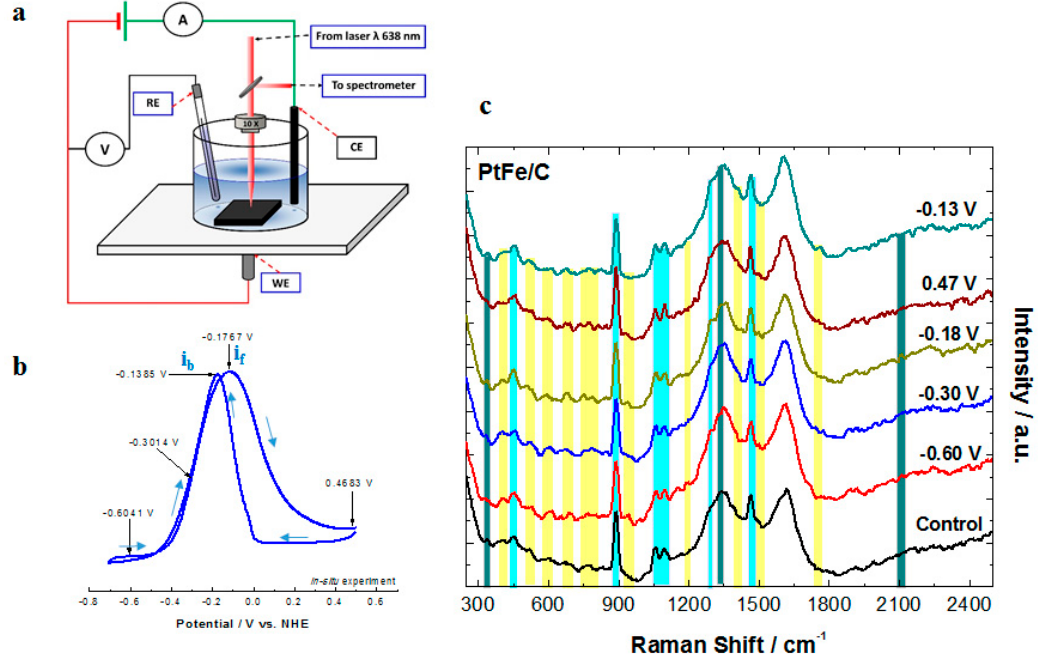
Figure 8. ( a ) Schematic representation of the cell arrangement between the electrochemical cell and Raman spectrometer; ( b ) Cyclic voltammogram of PtFe/C catalyst towards 1 M ethanol oxidation in alkaline medium (0.3 M KOH) at 1 mV · s − 1 , illustrating voltages in which SERS was performed (forward and backward sweep potential); ( c ) SERS spectra of chemical changes occurred during the ethanol oxidation on PtFe/C.